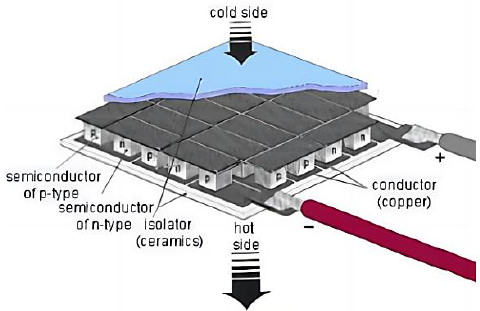
Figure 4. Schematic diagram of semiconductor refrigeration technology.